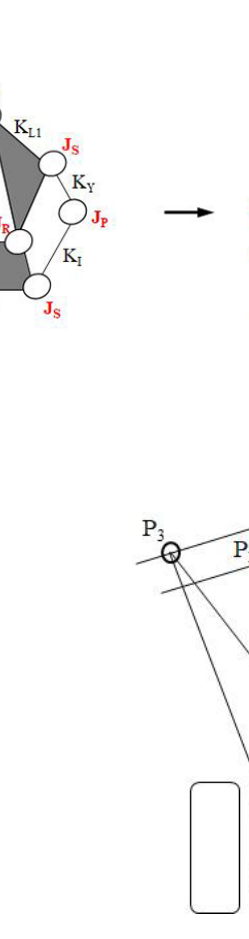
Figure 11. Model of front suspension.